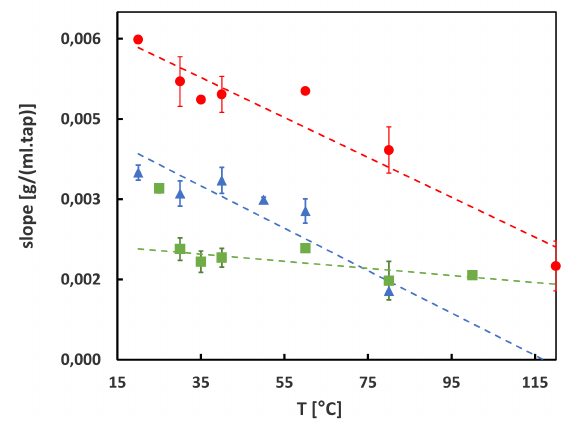
Figure 3. Evolution of the packing initial slope α as a function of the temperature for lactose powder (red dots), dried milk (blue triangles) and cocoa (green squares). Error bars are ± the stan- dard deviation around the mean computed from three repeatabil- ity